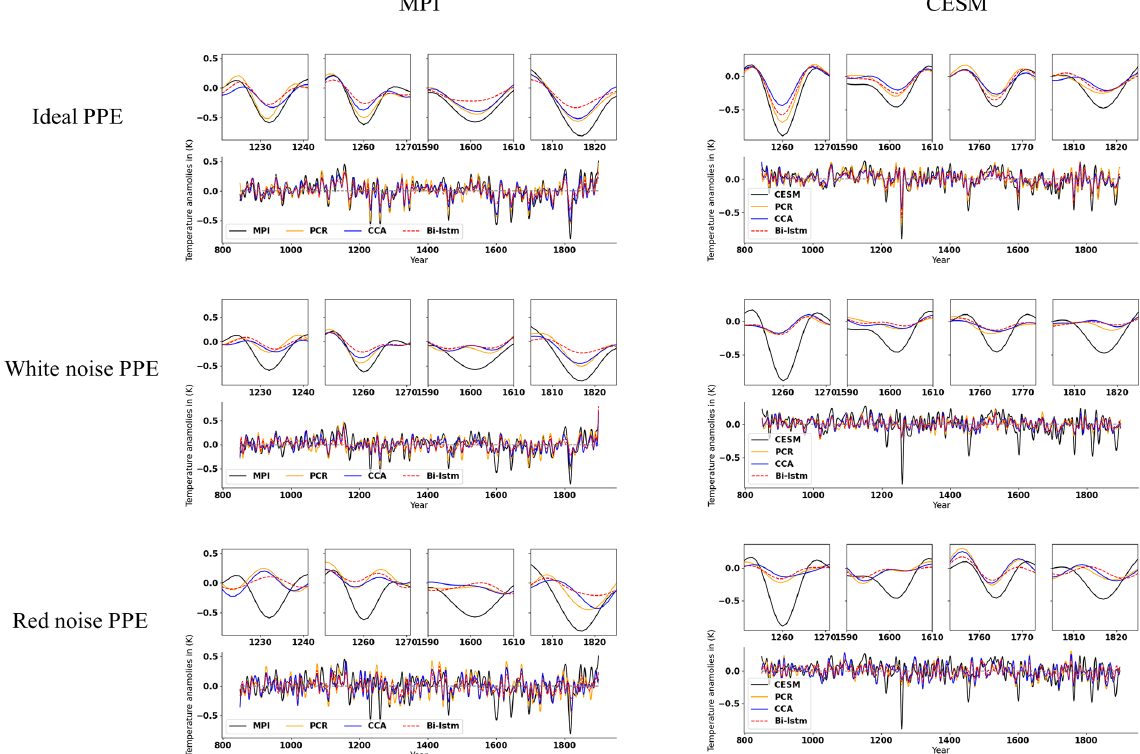
Figure 11. Mean time series evolution of the validated reconstructions for the NH summer temperature anomaly using the full set of 48 pseudoproxies based on PCR, CCA, and Bi-LSTM CFR methods. All time series have been smoothed using a Butterworth low-pass filter to remove temporal fluctuations shorter than 10 years. MPI and CESM represent MPI/CESM model-simulated “true” climatology. We selected several reconstructed extreme cooling periods with a shorter interval (10-year periods are selected before and after the specific extreme cooling year) and plotted them above the indices subfigure of the entire